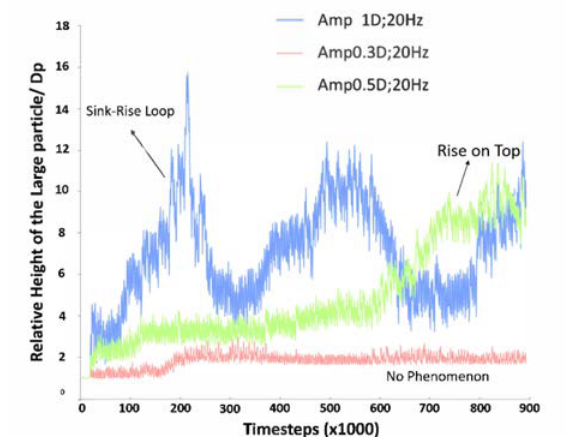
relative to the vibrated base.